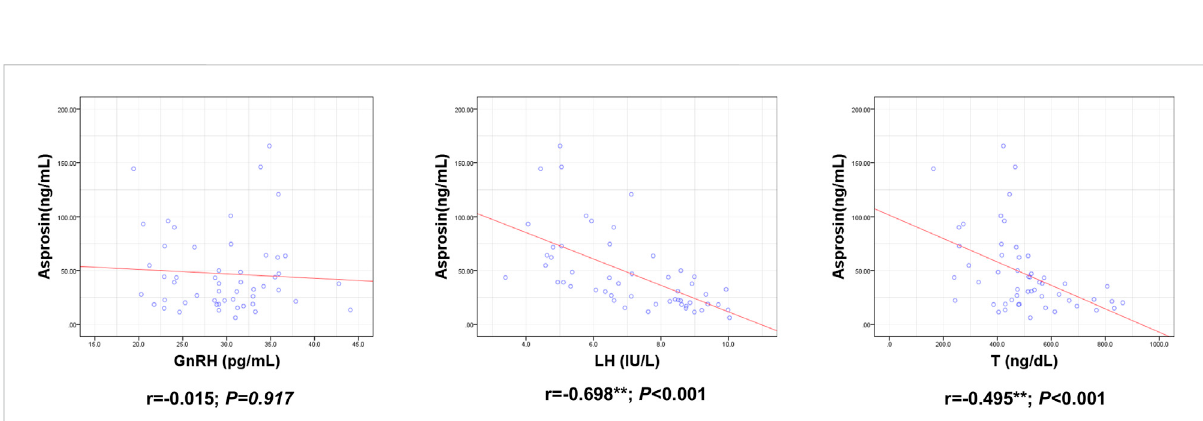
FIGURE 6 Correlation between Serum asprosin and HPG axis related indexes. r-correlation coef fi cient, p < 0.05 — level of statistical signi fi cance.